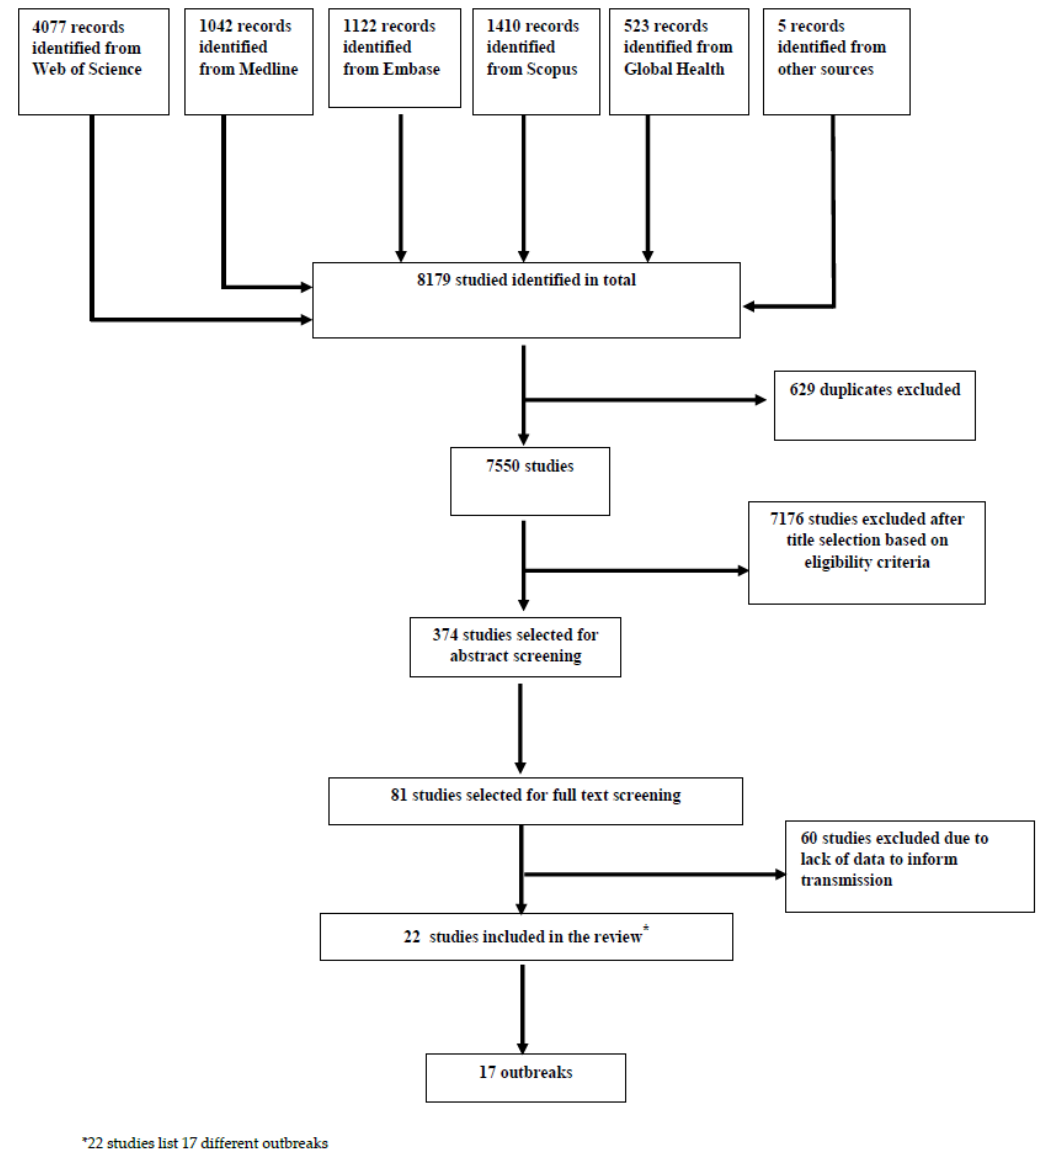
Figure 1. Search process for systematic review [34].